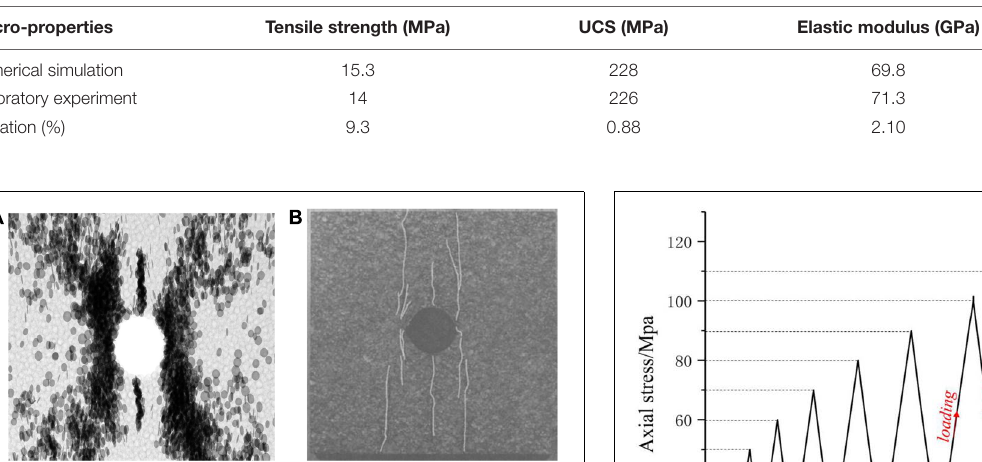
TABLE 3 | Comparison of macro-properties determined by numerical simulation and laboratory experiment.